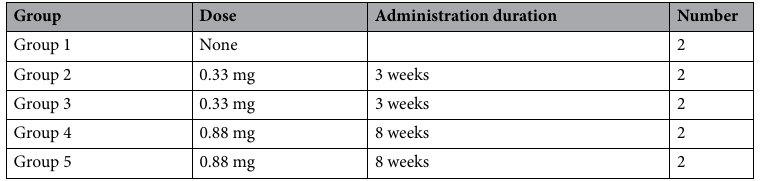
Table 1. Animal grouping for the oral administration model. The animals were divided into a control group (group 1) and experimental groups (groups 2, 3, 4, and 5).